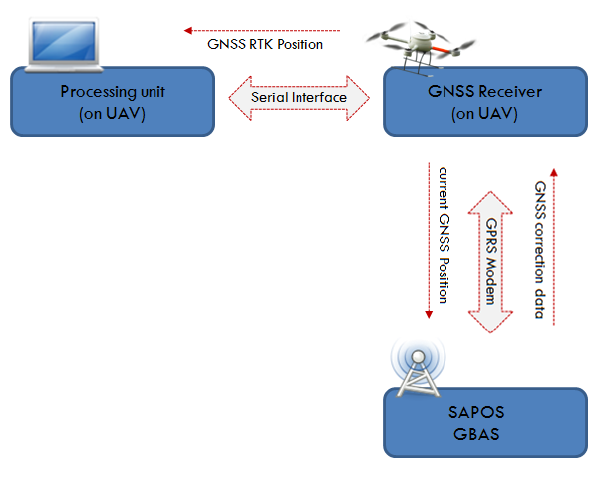
Figure 2: RTK high-level architecture.